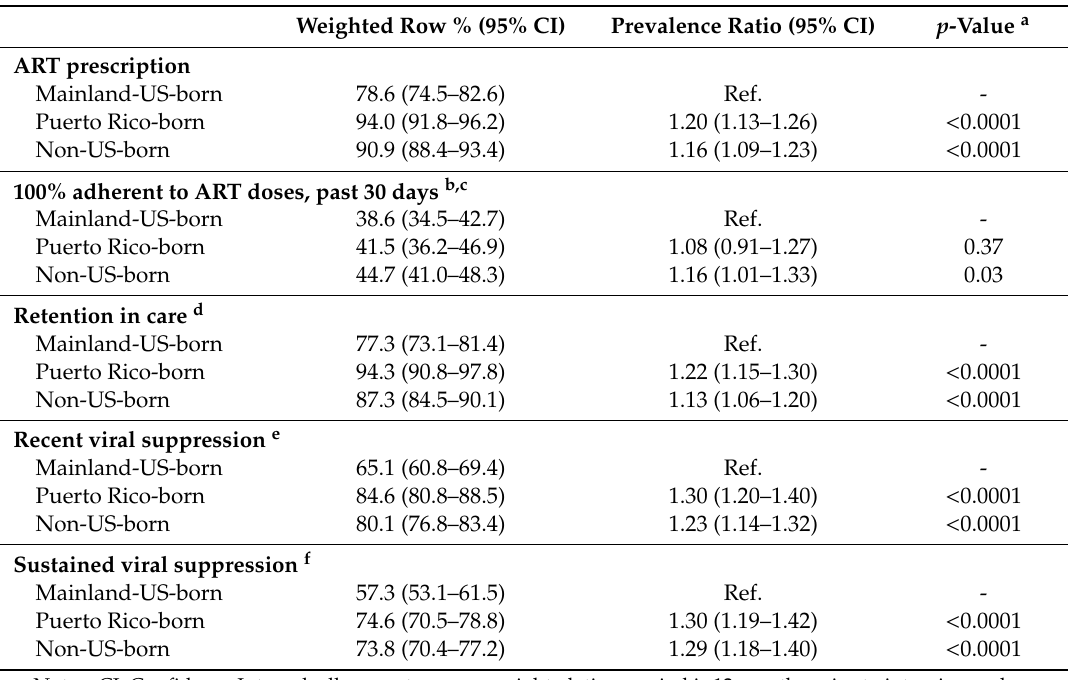
Table 3. HIV outcomes among Hispanic / Latino adults with diagnosed HIV by place of birth, United States—Medical Monitoring Project, 2015–2018 (n =